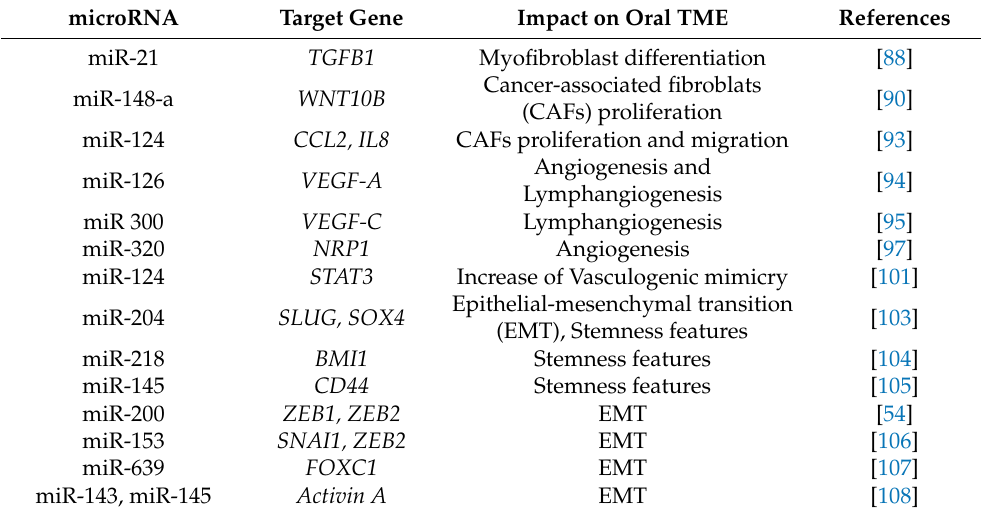
Table 2. Relevant examples related to the altered microRNA affecting tumor microenvironment (TME)